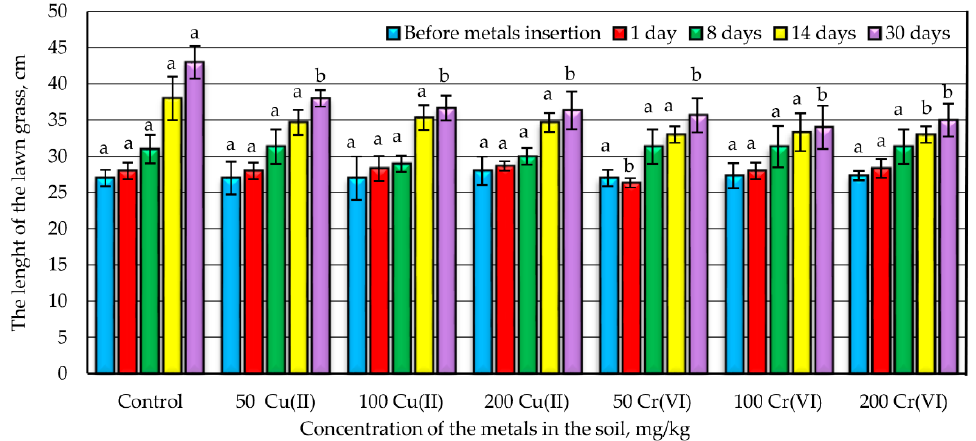
Figure 3. The influence of the metals on the length of lawn grass ( х ± SD, n = 5); p < 0.05.